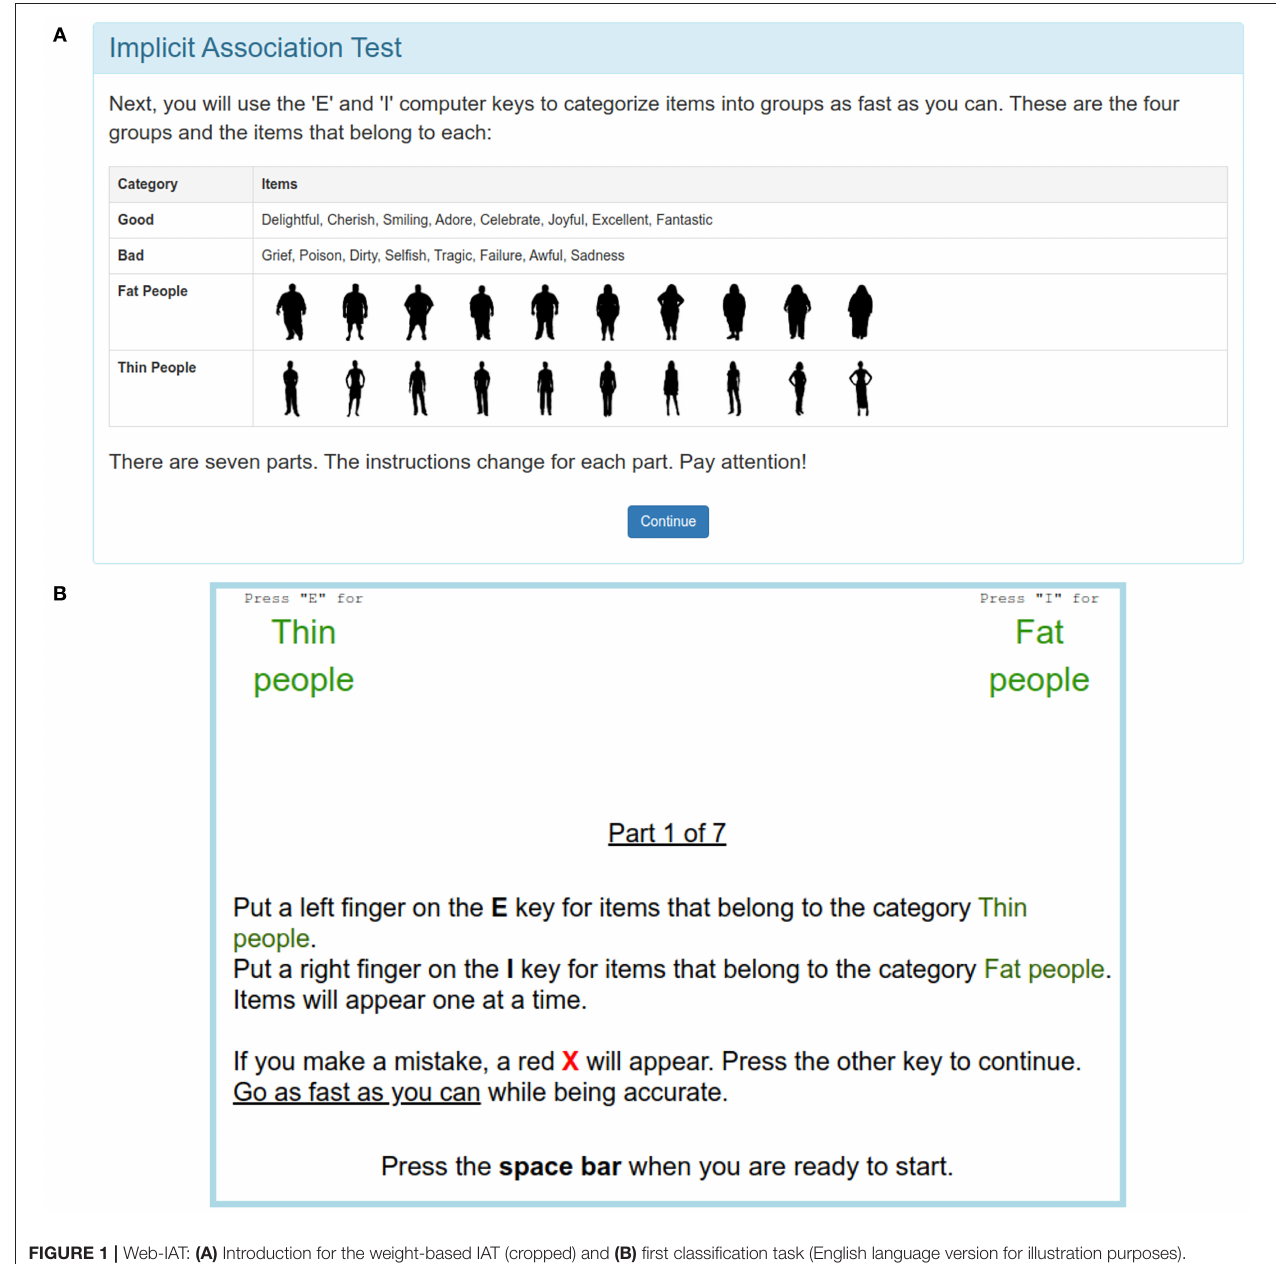
using R (version 4.1.2) for both descriptive as well as statistical